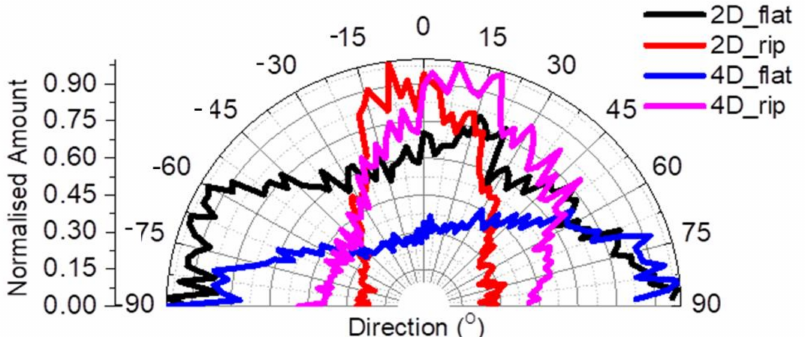
Figure 9. Directional Polar Plot of NIH 3T3 fibroblasts’ cytoskeleton on the flat and ripples area of sample 2 for 2 and 4 days; the black and blue lines represent the flat area at 2 days and 4 days respectively, while the red and magenta lines represent the ripples area at 2 days and 4 days,